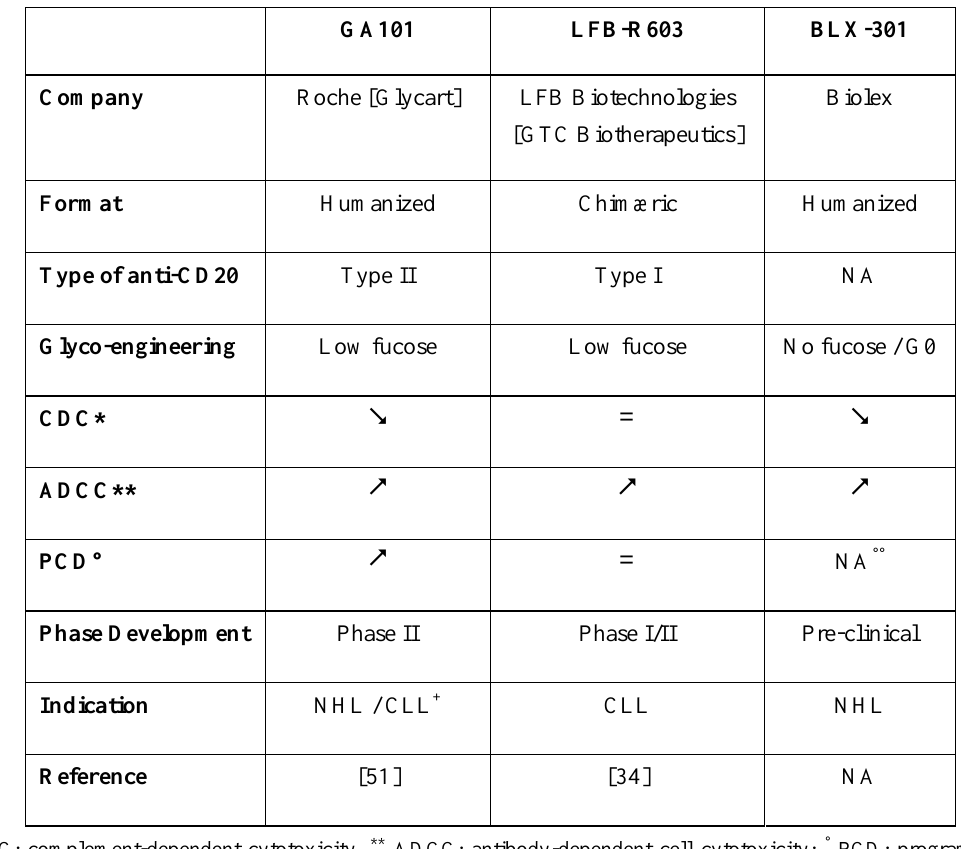
Table 1. Second generation glyco-engineered anti-CD20 antibodies currently in clinical